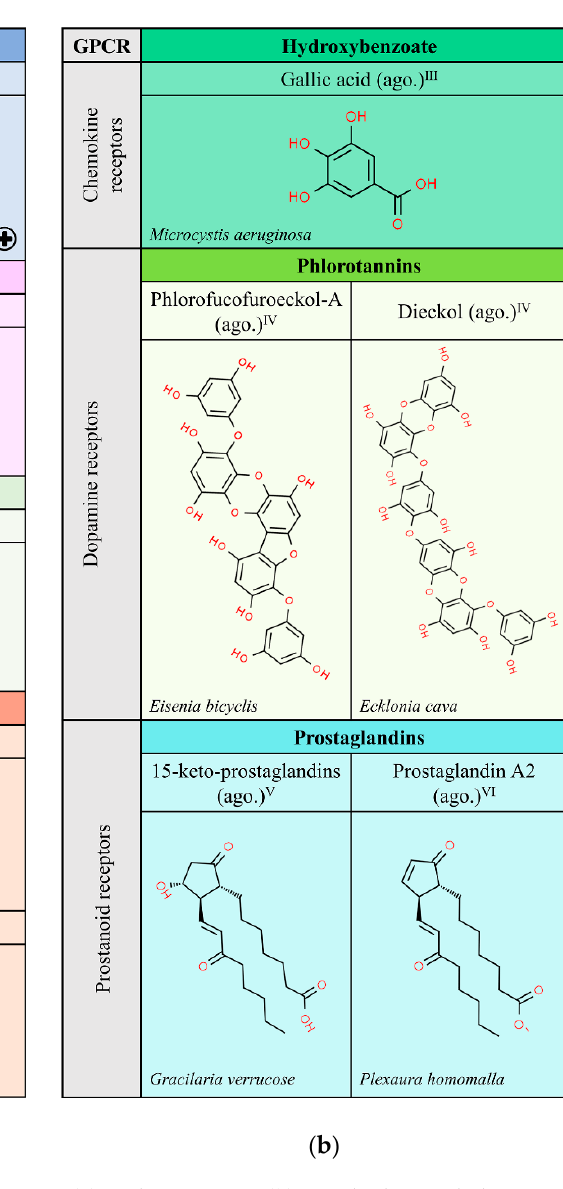
Figure 1. Natural ligands of GPCRs from Bacteria ( a ) and Protoctists ( b ). Each chemical class is highlighted with di ff erent colors. The chemical structures were found on ChemSpider website. Legend: the plus symbol means that this compound is approved by the Food and Drug Administration;